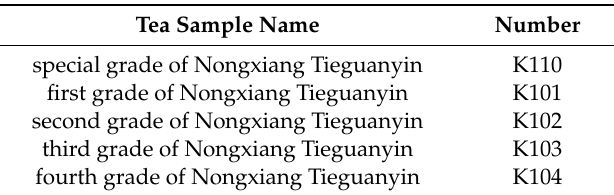
Table 3. Tea samples used in the